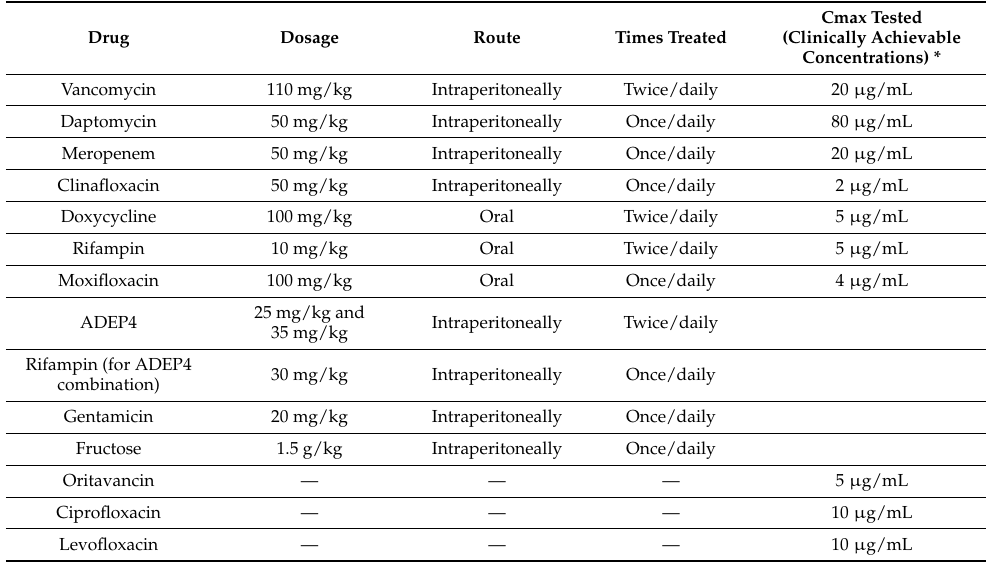
Table 1. Drug dosage, scheduling, and